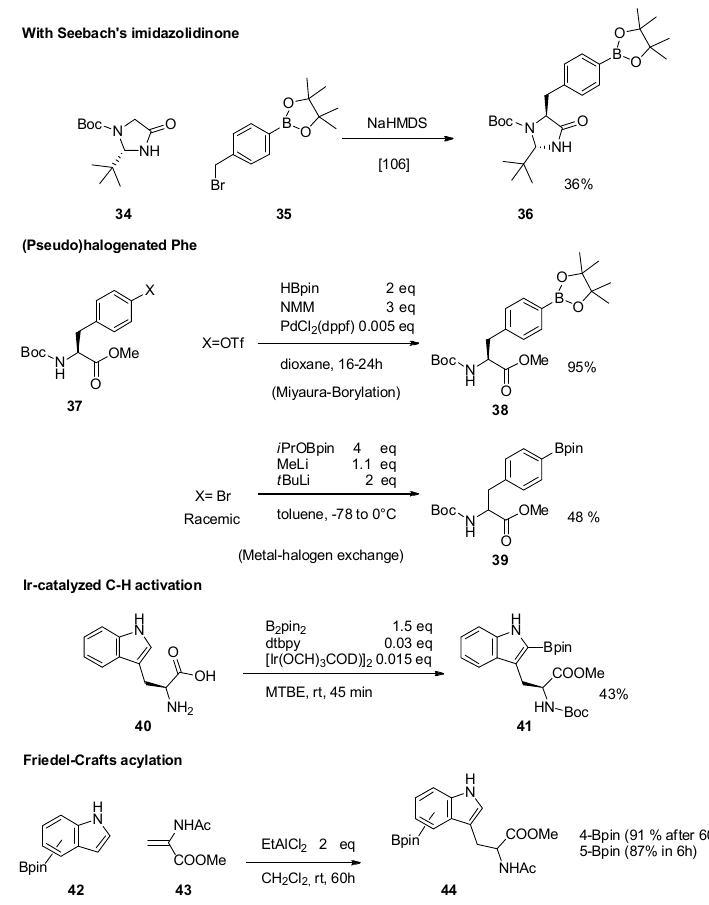
Figure 7. Representative examples of methods to prepare pinacolyl arylboronate esters. Figure 8. Representative examples of methods to prepare pinacolyl arylboronate